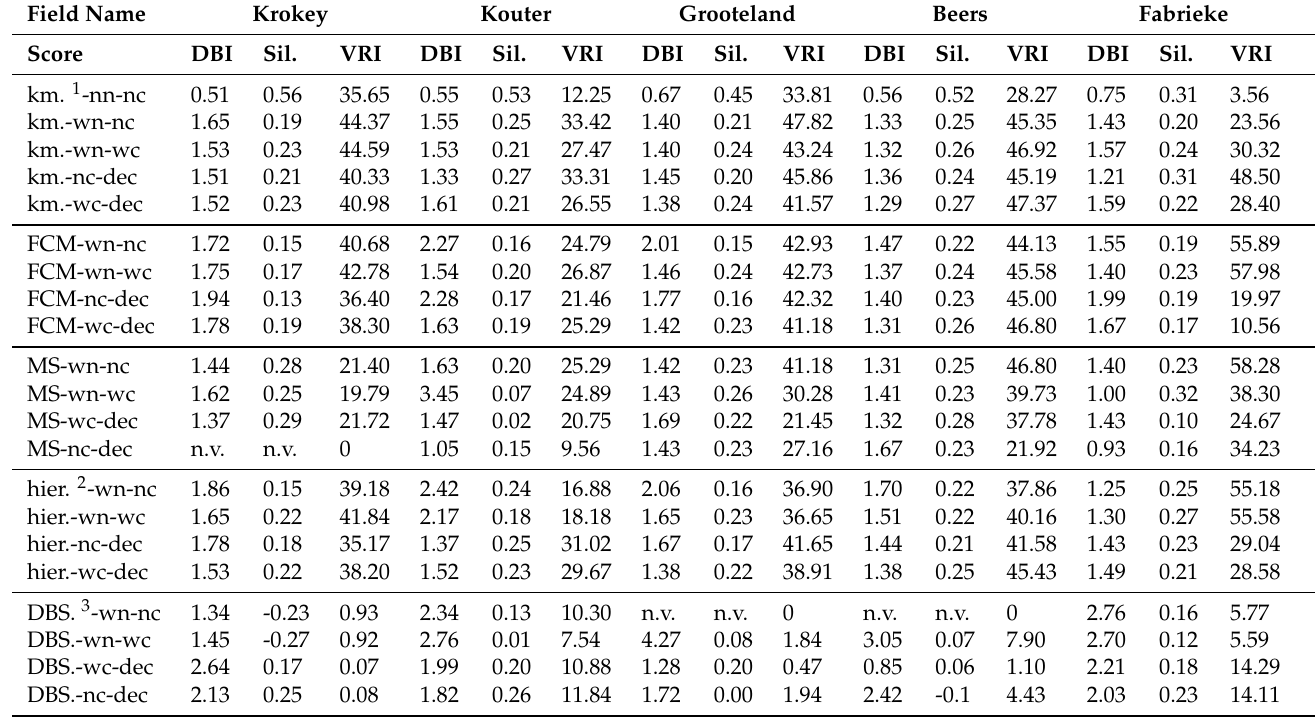
Table 3. Evaluation of clustering methods including k -means, fuzzy C-means (FCM), mean shift (MS), hierarchical, and density-based spatial clustering of applications with noise (DBSCAN) in terms